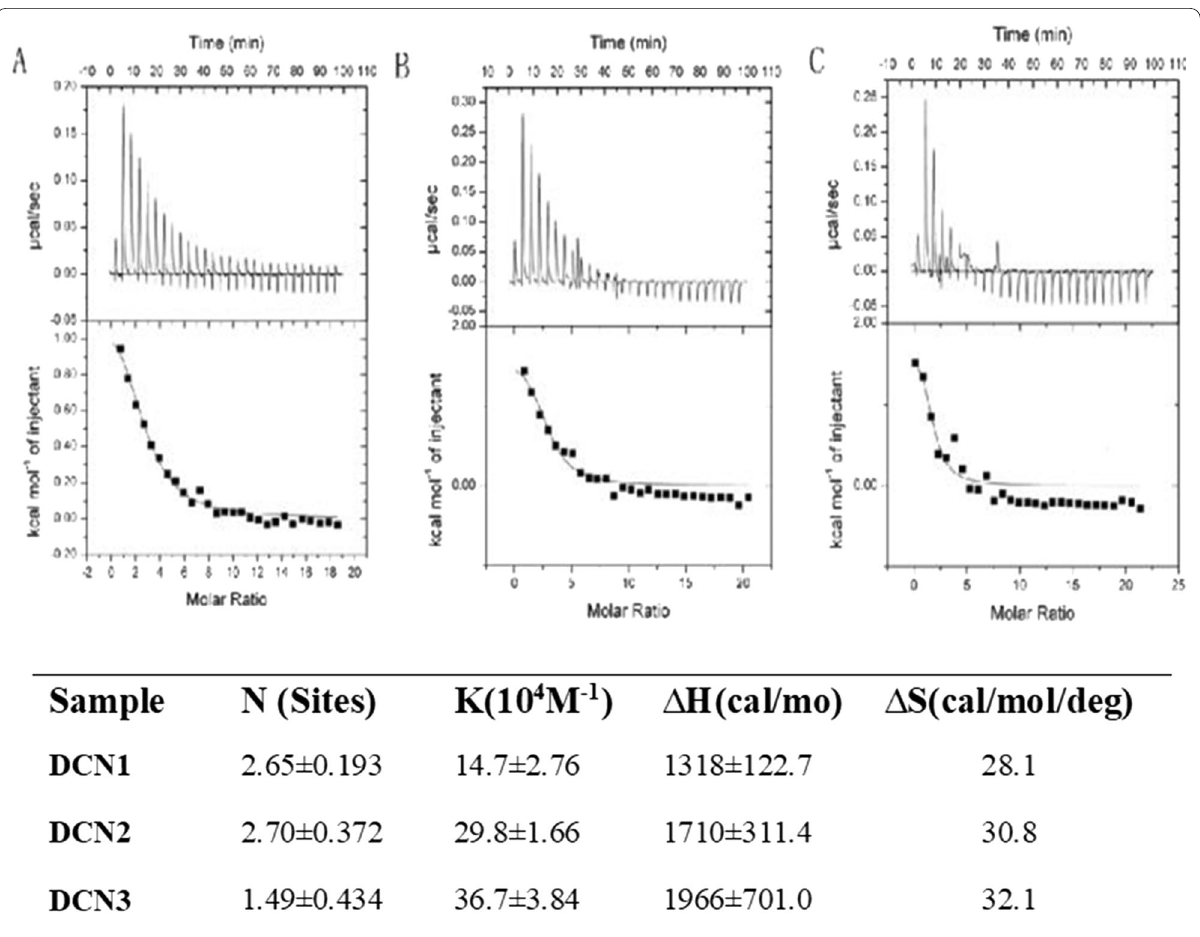
Fig. 2 Isothermal calorimetry data for PS (0.9 mM) titration into a DCN1, b DCN2 and c DCN3 (0.02 mM) solutions at 25 °C. Degree of coverage, affinity (KA) and enthalpy and entropy changes for PS binding with nanoparticles (NPs) after titration into NP